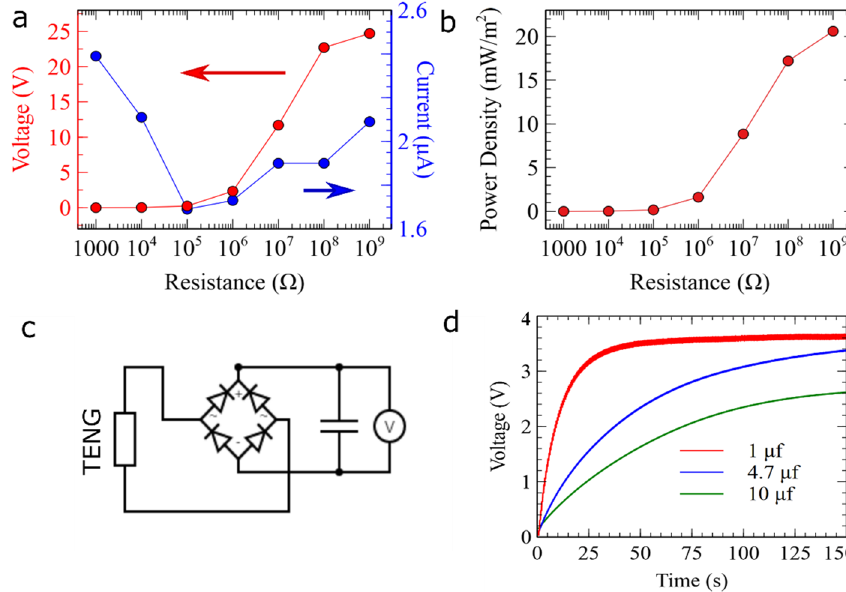
Fig. 5 a PVDF-paper and Thick Rubber TENG voltage (red) and current (blue) as a function of load resistance.